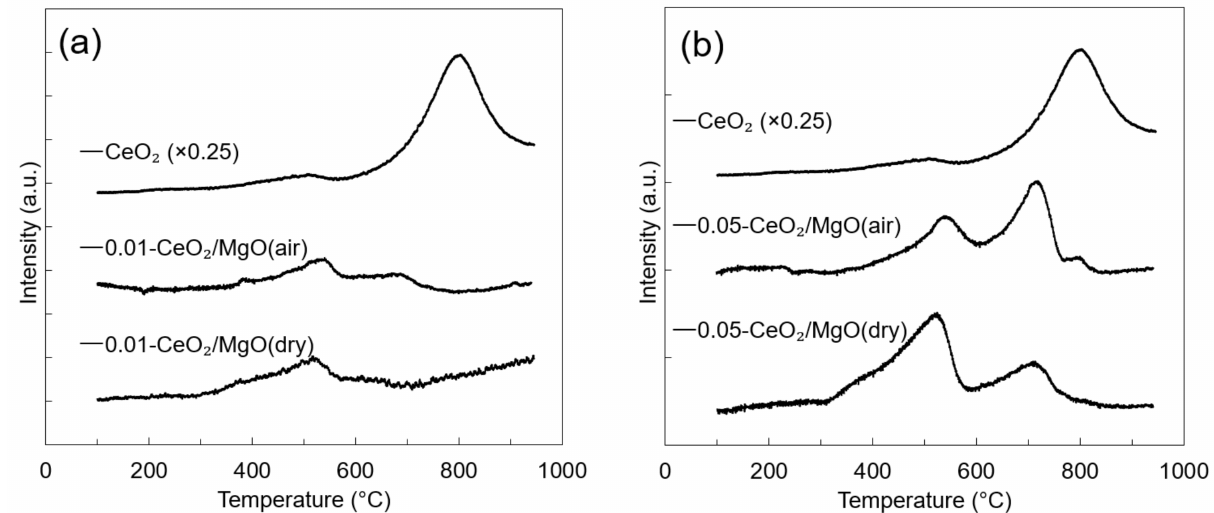
Figure 4. H 2 -TPR profiles of ( a ) 0.01-CeO 2 /MgO and ( b ) 0.05-CeO 2 /MgO catalysts compared to that of pure CeO 2. Redox properties of the catalysts were further assessed by TPO using CO 2 as an oxidant. The catalysts were reduced in a 5%H 2 /Ar flow at 550 ◦ C before the TPO measure- ments. As shown in Figure 5, the formation of CO starts at ~350 ◦ C on all the catalysts. Further, the peak intensity is ~1.5 times higher on 0.05-CeO 2 /MgO(dry) compared to those on 0.05-CeO 2 /MgO(air) and pure CeO 2 . These results are consistent with the H 2 -TPR (Figure 4b); the reduction peak at ~500 ◦ C on 0.05-CeO 2 /MgO(dry) is larger than those of